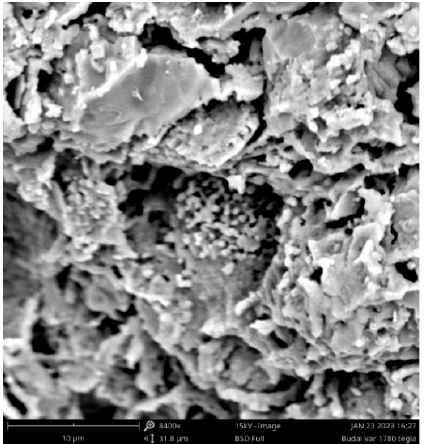
Figure 2. SEM image of historic brick.